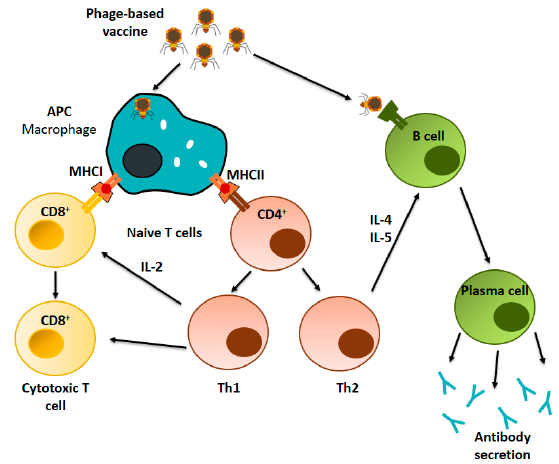
Figure 3. Immunological mechanism of phage-based vaccines. Phage-based vaccines can stimulate both humoral and cellular responses. Phage particles displaying-antigens are taken up by APCs. The